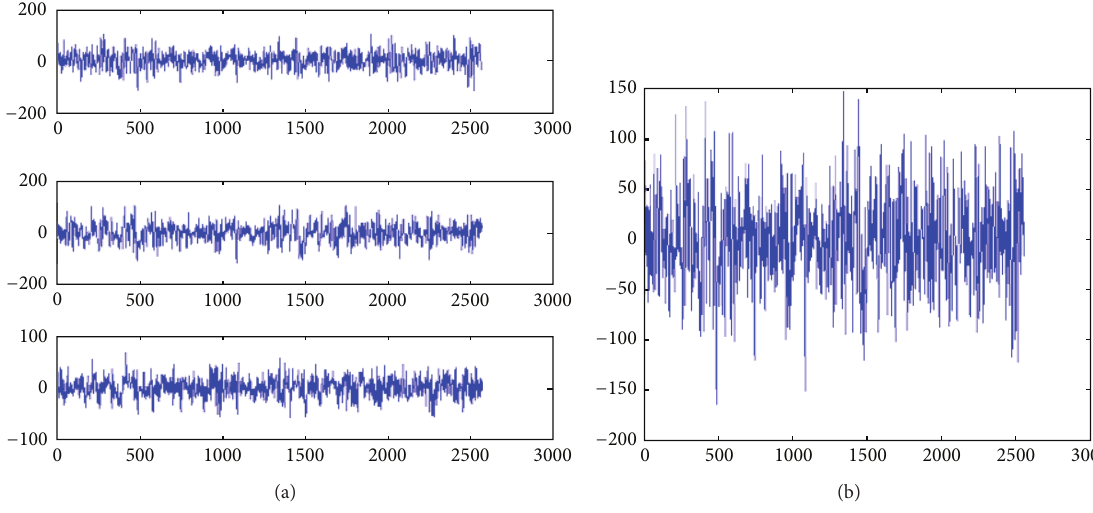
Figure 3: Application of PCA on left temporal lobe channels